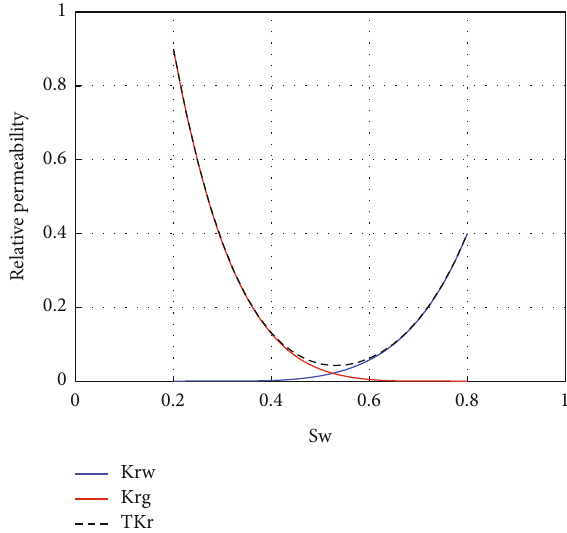
Figure 12: Permeability curve of each phase fl uid and comprehensive phase permeability